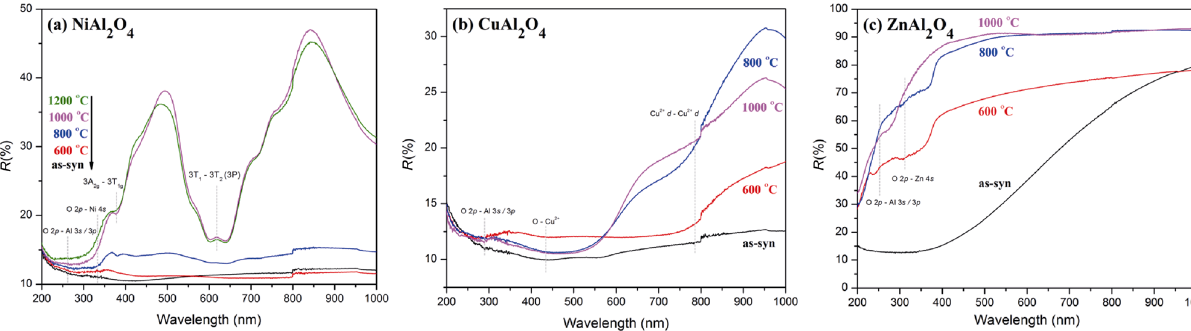
Fig. 5 UV-DRS diffuse reflectance spectra of (a) NiAl 2 O 4 , (b) CuAl 2 O 4 , and (c) ZnAl 2 O 4 powders calcined at different